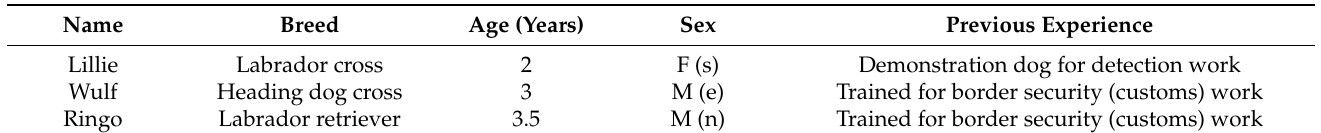
Table 1. Details of the dogs used in this study, s: spayed, e: entire (not neutered), n: neutered. Heading dog is a NZ sheep herding dog breed derived from Border Collies.